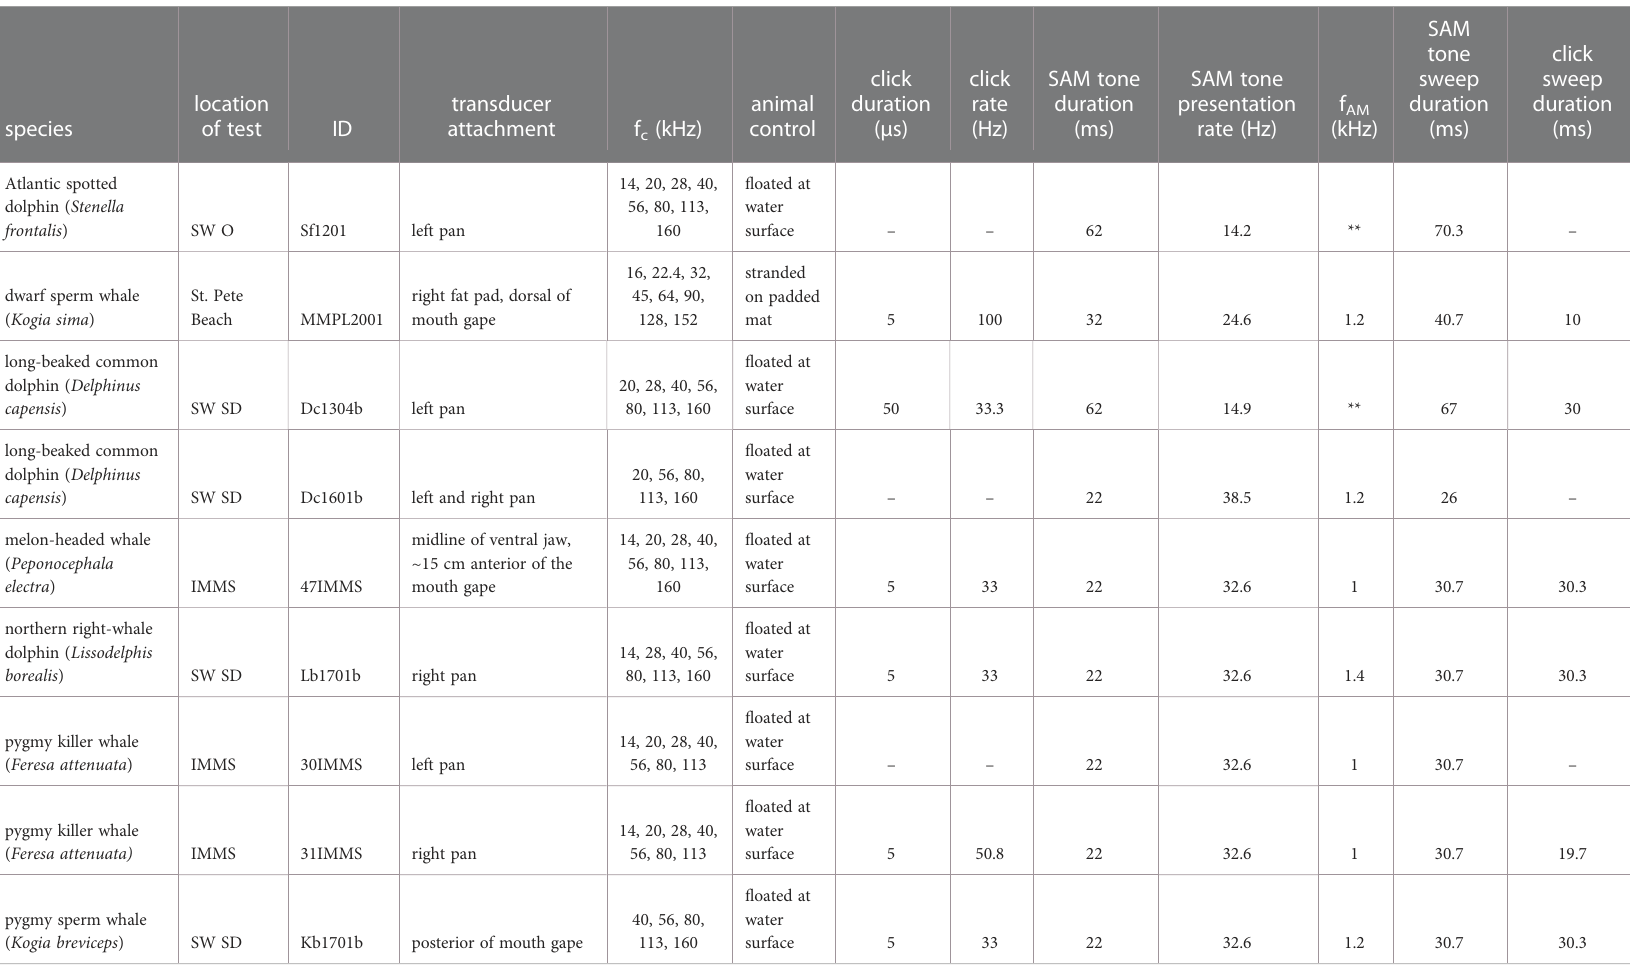
TABLE 1 Species tested, animal ID, location of test (SW O, SeaWorld Orlando; SW SD, SeaWorld San Diego; IMMS, Institute for Marine Mammal Studies), and animal control during testing. Test parameters include: transducer attachment location, center frequency (f c ) of test stimuli, click duration and presentation rate, SAM tone duration, rate of presentation, and amplitude modulation rate (f AM ), and the sweep duration used for evoked response AEP